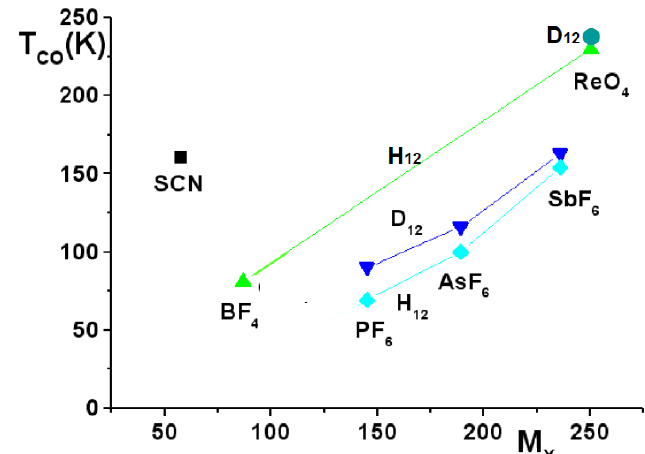
Figure 8. T in function of the anion (labeled by its mass M CO deuterated (D ) (TMTTF) X (adapted from [112]). The continuous lines connect T 12 2 H and D salts with anions of same 12 12